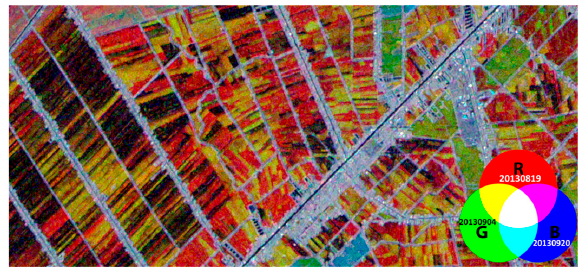
Figure 6. Example of RGB combinations of different dates (R: 19/08/2013, G: 04/09/2013, B: 20/09/2013) from CSK images, HH polarization over rice fields in the An Giang Province. To interpret the backscatter temporal variation of individual rice fields, the backscatter coefficients need to be expressed as a function of the plant age (days after